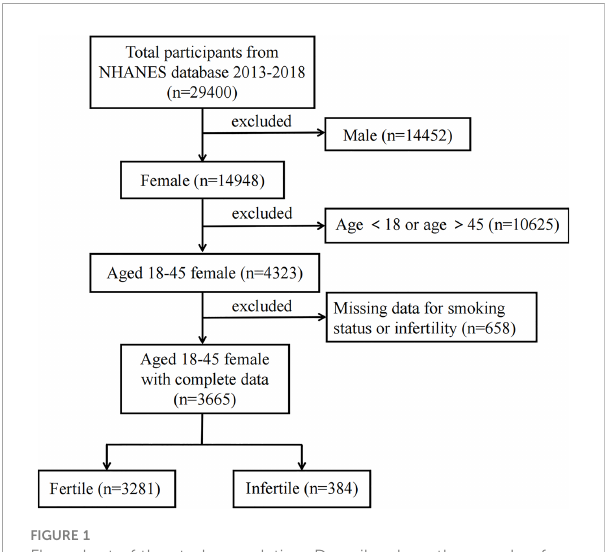
FIGURE 1 Flow chart of the study population. Describes how the sample of participants was composed. NHANES, National Health and Nutrition Examination